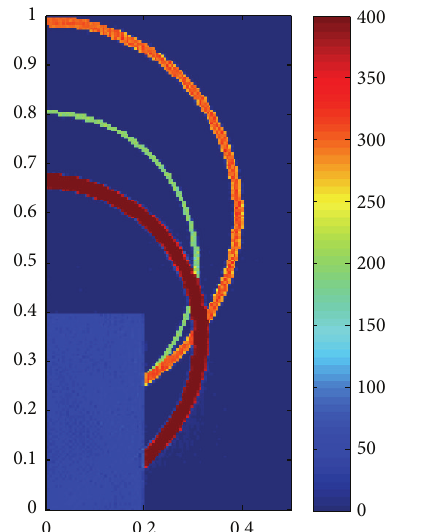
Figure 3: The reconstructed result of the phantom object.